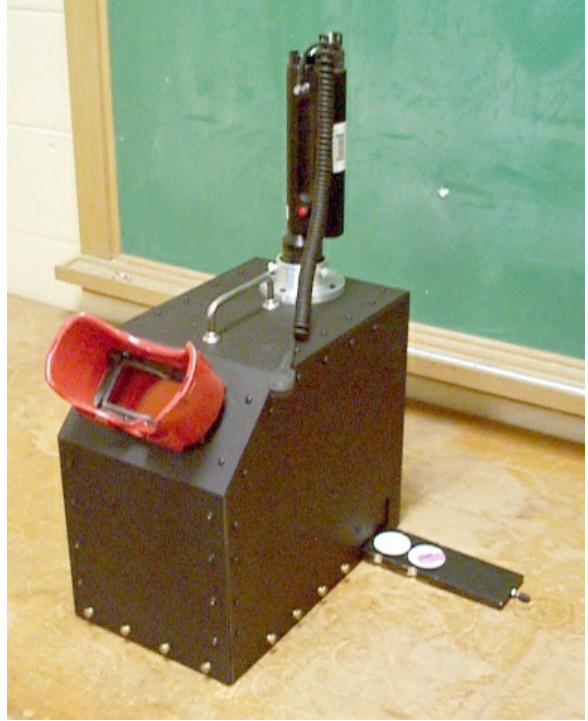
FIGURE 2 . Field device for explosives photoluminescence detection with